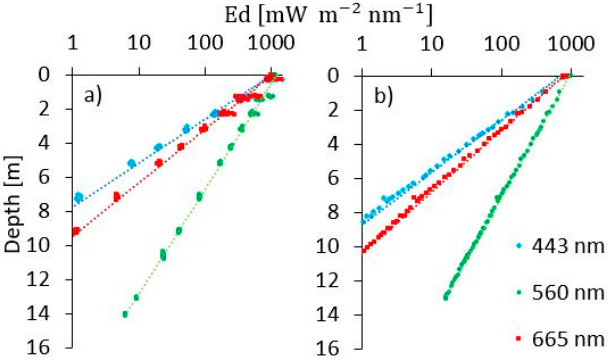
Figure 5. Examples of linear profiles for logarithm scale of E d ( z; λ ) : ( a ) P15 2013; and, ( b ) TRM09 2019.